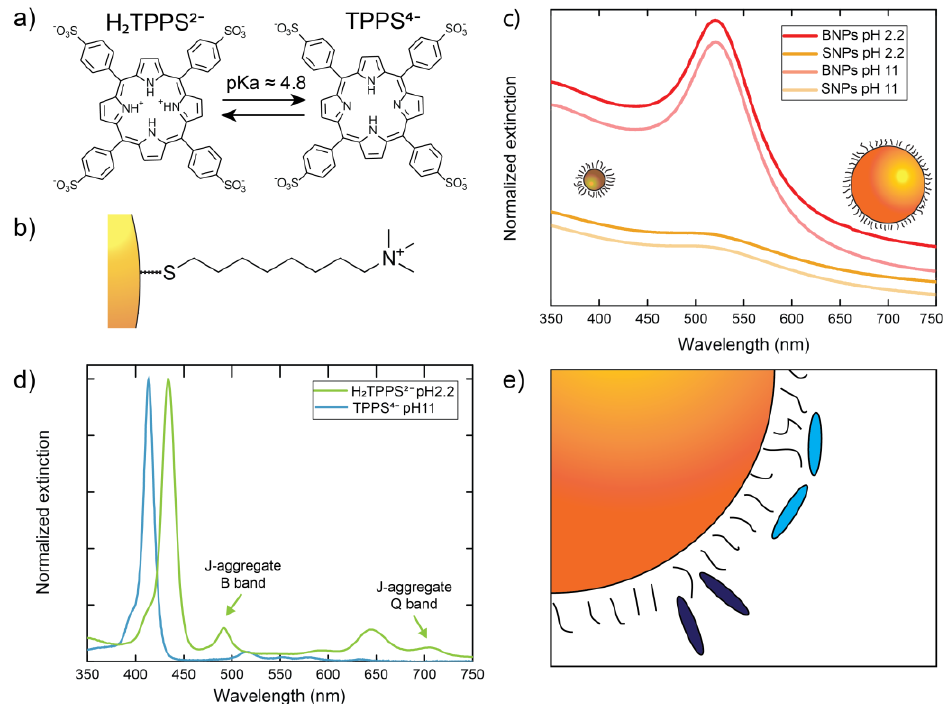
Figure 1. Components of the hybrid systems. ( a ) Molecular structures of diprotonated and free base porphyrin, labelled H 2 TPPS 2 − , and TPPS 4 − , respectively. ( b ) Representation of the TMAO-SH capping layer molecule. ( c ) Extinction spectra of big (BNPs) and small (SNPs) nanoparticles at different pH. The spectra are shifted vertically to ease the comparison. The cartoons of big and small nanoparticles are represented in scale. ( d ) Normalized extinction spectra of H 2 TPPS 2− at pH = 2.2 and of TPPS 4− at pH = 11 (1 μM solutions in MilliQ water). The two arrows indicate the B and Q bands of TPPS J-aggregate, allowing them to be distinguished from the bands of the monomer. ( e ) Schematic representation of the perpendicular (dark blue) and parallel (light blue) orientation of the porphyrins on a nanoparticle surface.